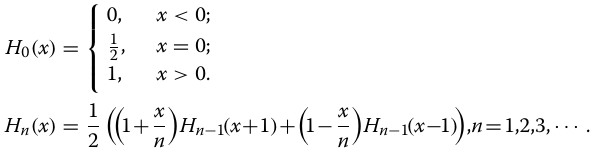
( x , y ) is specified using the same set of vertices P , δ